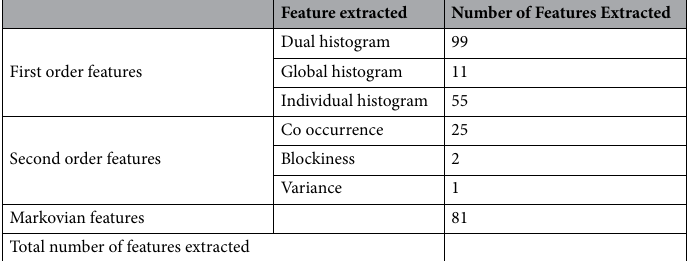
Table 2. Table of extracted features.